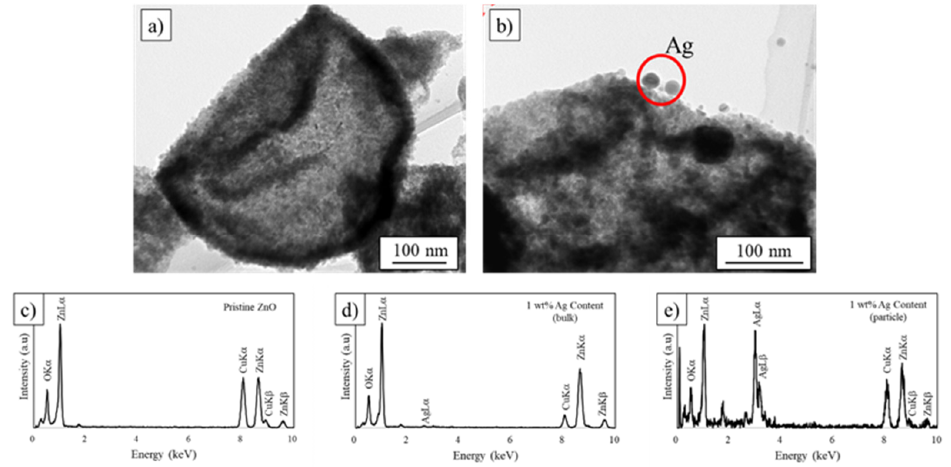
Figure 2. TEM-EDS of ( a , c ) Pristine ZnO and ( b , d , e ) ZnO-Ag nanoparticles at Ag content of 1 wt%.